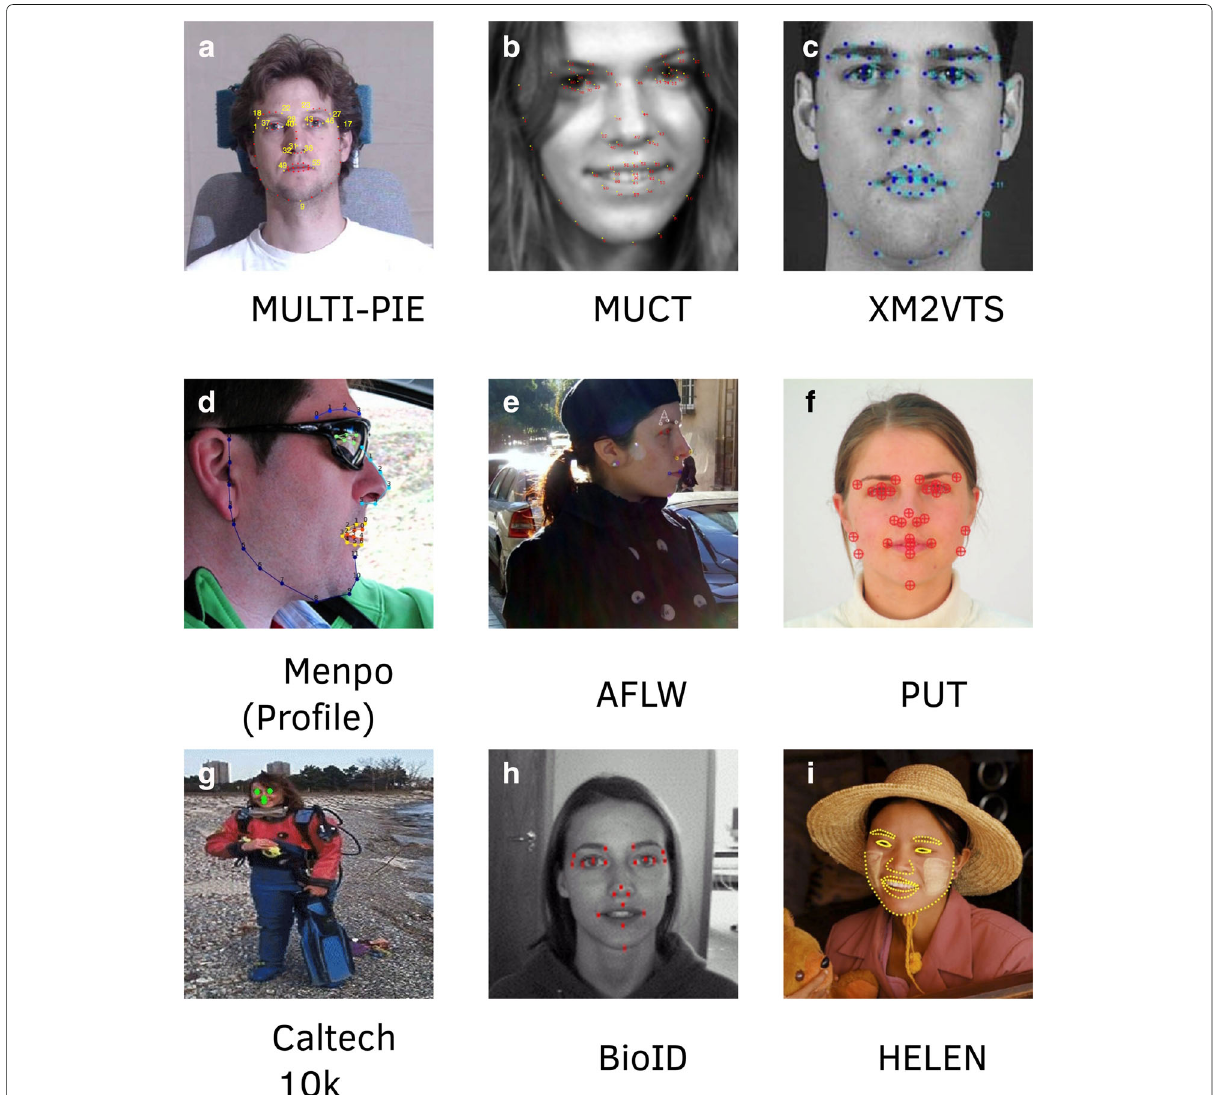
Fig. 2 Examples from public face datasets. These images demonstrate the variety of image types and landmark configurations available within public face datasets. a MULTI-PIE [75], b MUCT [76], c XM2VTS [77], d Menpo (Profile ) [78], e AFLW [79], f PUT [80], g Caltech 10K [81], h BioID provided by BioID AG. ©2001 [82], and i HELEN